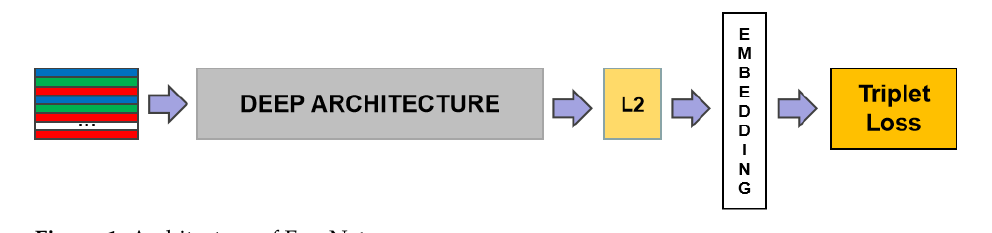
Figure 1. Architecture of FaceNet.